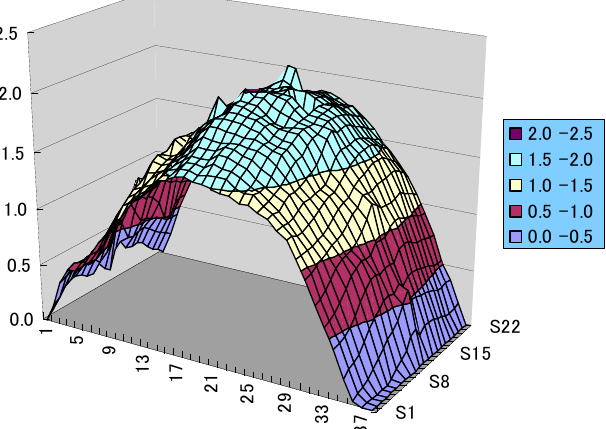
Figure 3. Out-of-plane geometrical imperfection scanned by DIC (Unit: mm). Figure 3. Out ‐ of ‐ plane geometrical imperfection scanned by DIC (Unit: mm).